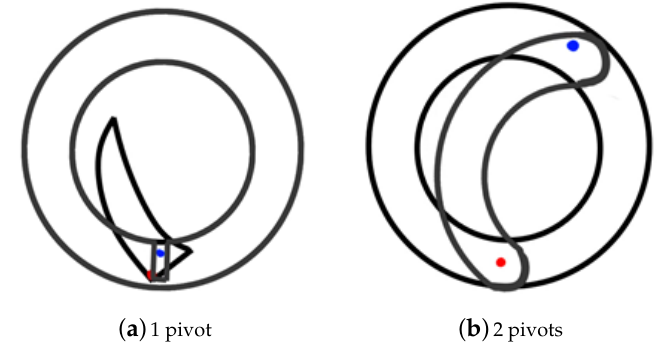
Figure 5. Different iris